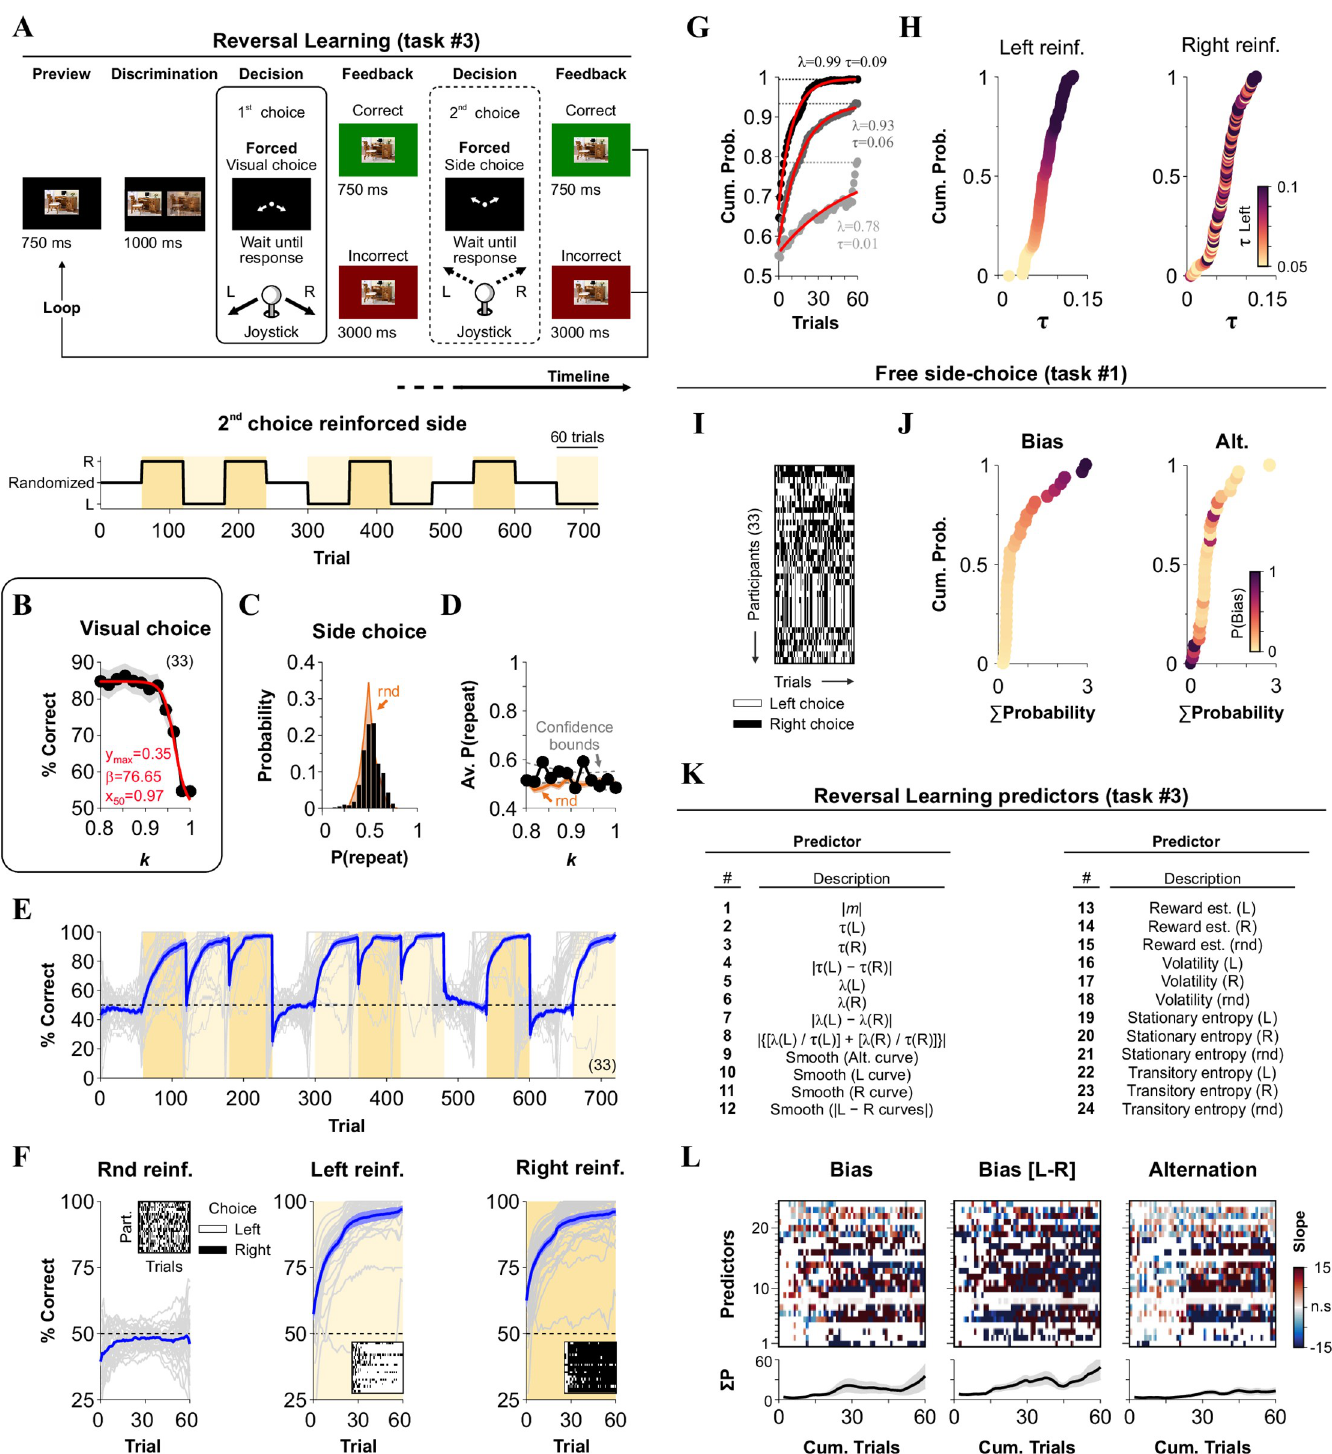
Fig 3. Comparing behavioral metrics from reversal learning with choice-biases from our free side-choice task. (A) Stimulus timeline of the reversal learning task (task 3), which consisted of a visual discriminative choice (1 st choice) followed by a forced side-choice (2 nd choice) during which we reinforced either left, right or alternating side-choices. (B) Average psychometric curve as a function of stimulus similarity (1 st choice). (C) Probability that side-choices involved the same side as the visual choice ( P (repeat side)). Orange distribution corresponds to a random process derived from a binomial distribution (same number of trials). (D) Average %correct side-choice (2 nd choice) is fully independent of stimulus discriminability during visual choice. (E) Average %correct side-choice (2 nd forced side-choice, blue line) while